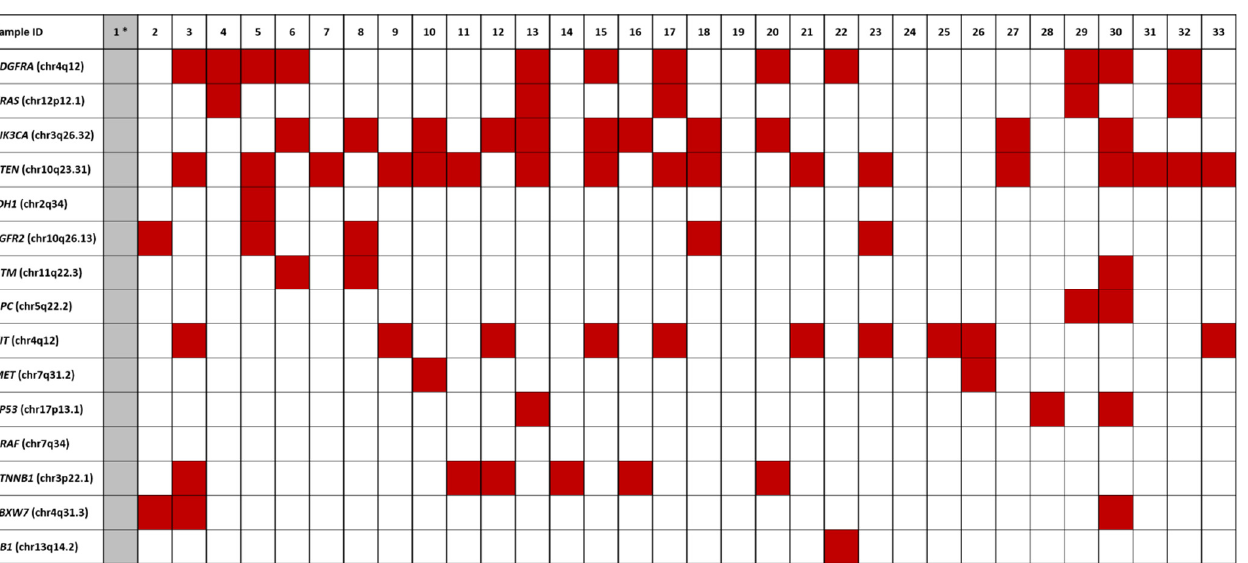
Table 4. Overview of the MSI findings.